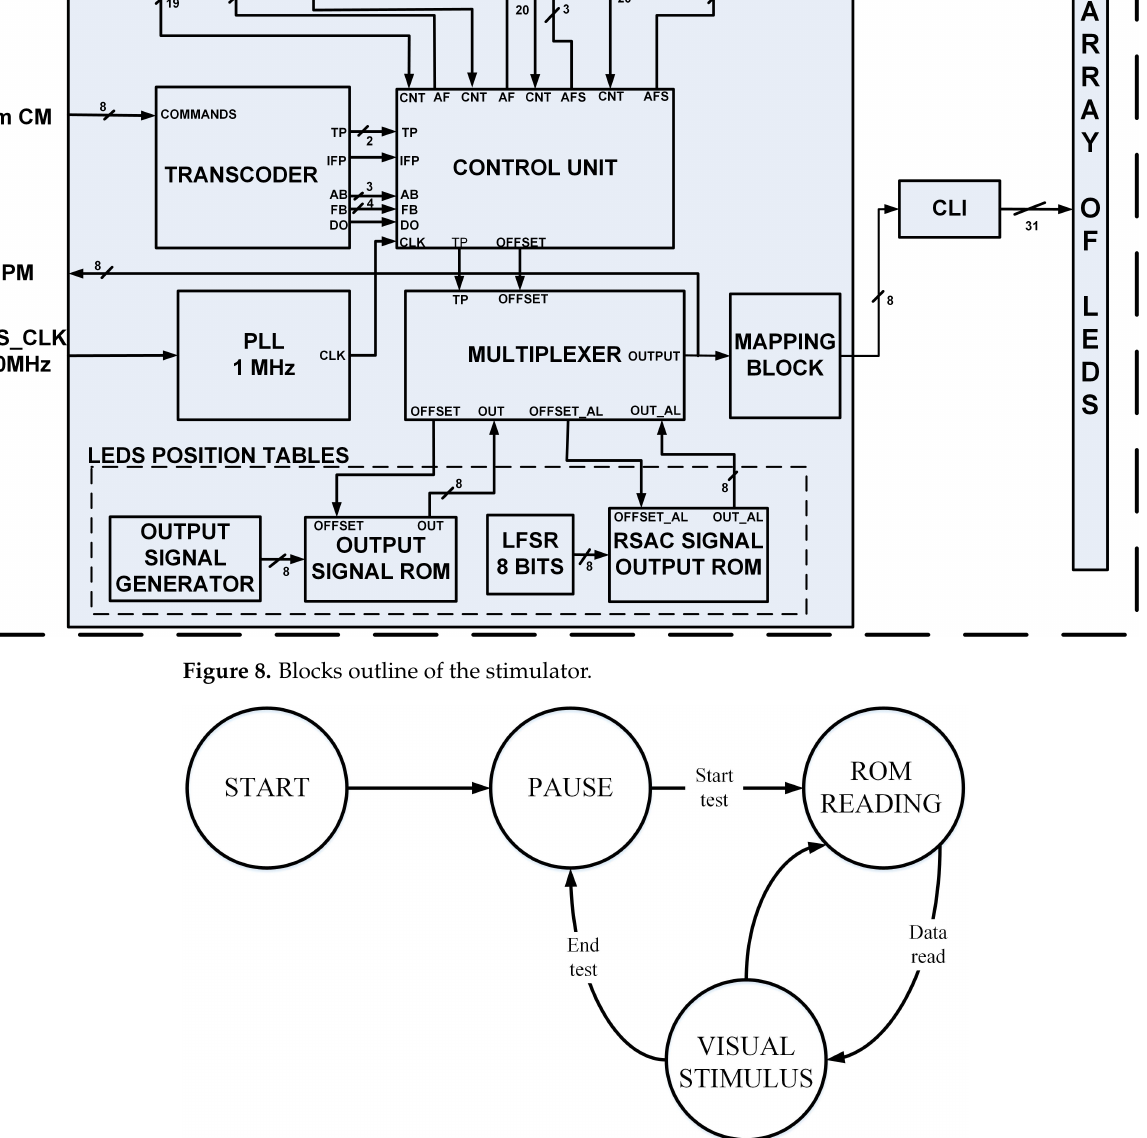
Figure 9. States of the Stimuli Generator